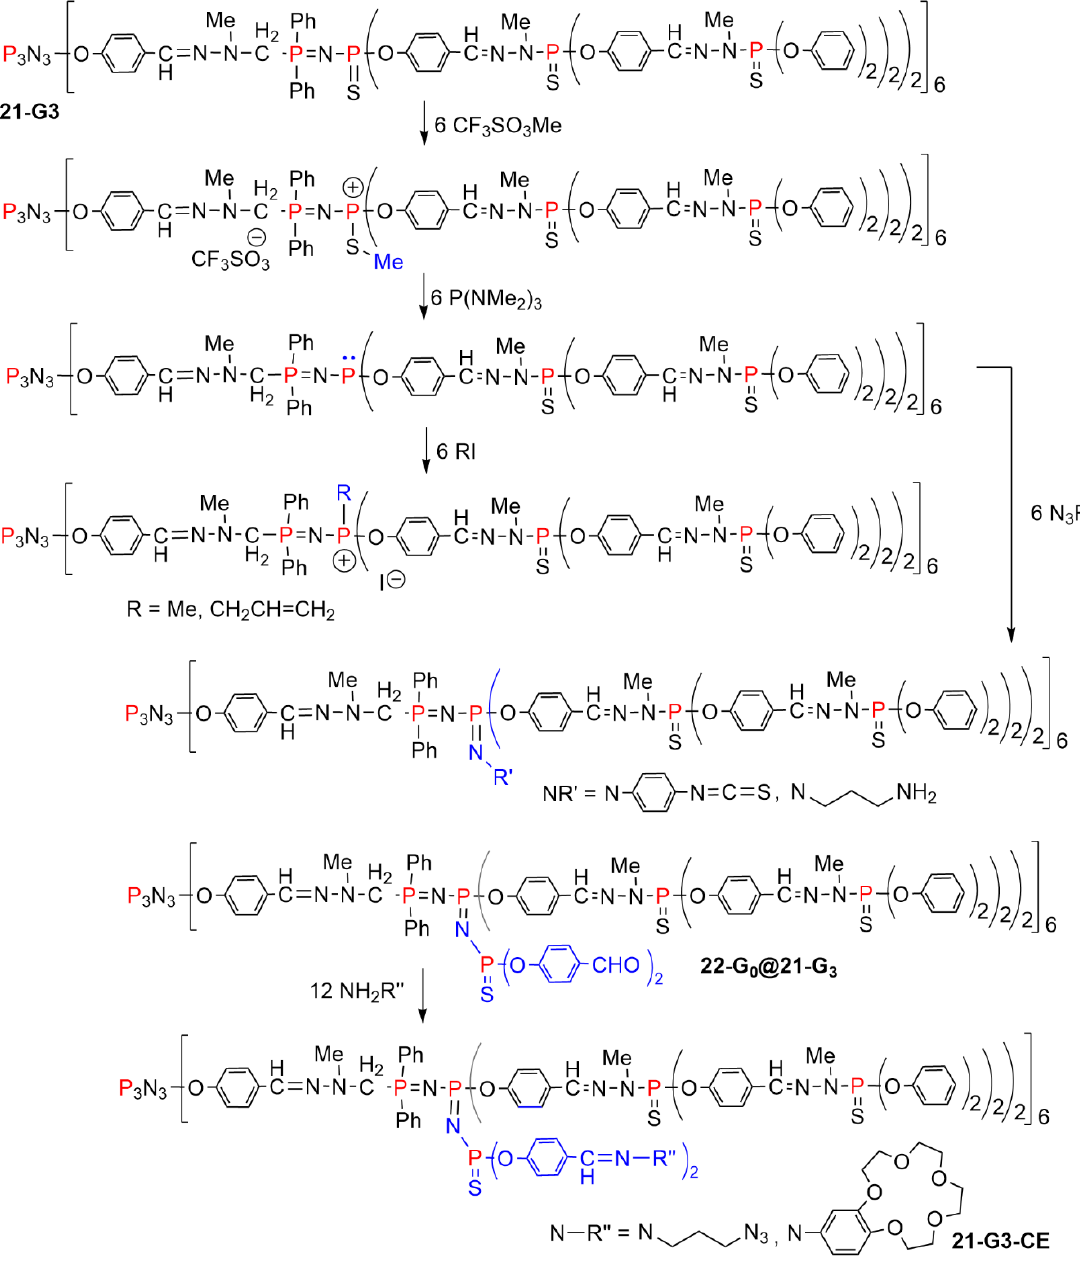
The presence of aldehyde functions inside the structure of dendrimers enabled the structure. Two different methods have been used to generate these new branches. One method used the classical way for the synthesis of phosphorus dendrimers [44–46] up to the twelfth generation [47], i.e., the condensation of the